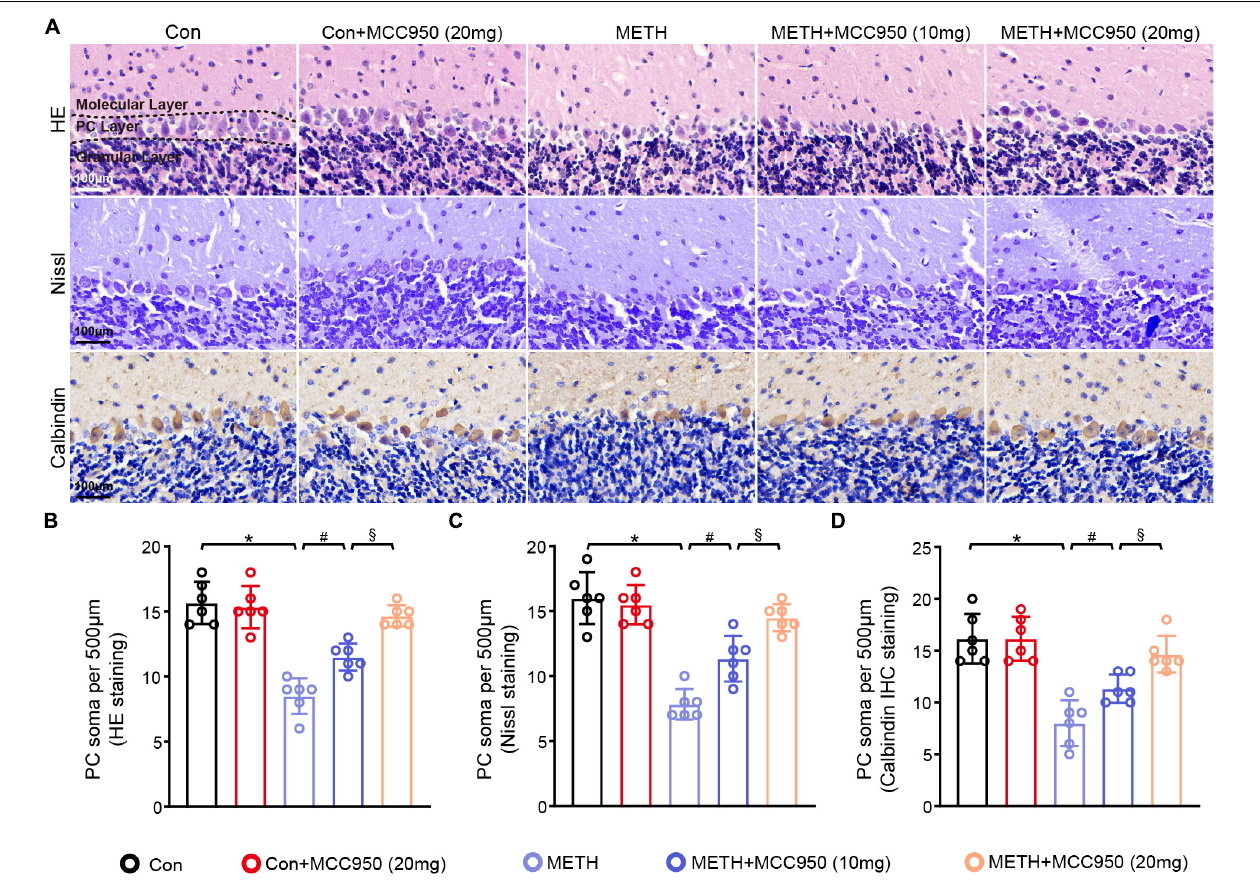
FIGURE 2 | MCC950 alleviated PC soma number loss in chronic METH mice model. (A) HE staining, Nissl staining and Calbindin IHC staining in the cerebellar area. (B) Comparison of PC soma number from HE staining results. (C) Comparison of PC soma number from Nissl staining results. (D) Comparison of PC soma number from Calbindin IHC staining results. n = 6 per group by one-way ANOVA and Bonferroni’s post-hoc analysis, * p < 0.05, compared with the Con group; # p < 0.05, compared with the METH-treated group; § p < 0.05, compared with the METH + MCC950 (10 mg)